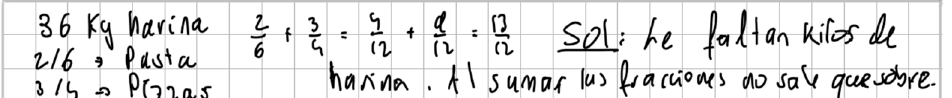
Figure 1. PT30’s written answer to problem FWP3. (Translation of P30’s solution: “The restaurant is short of kilos of flour [harina]. When adding up the fractions, there is no excess.”).